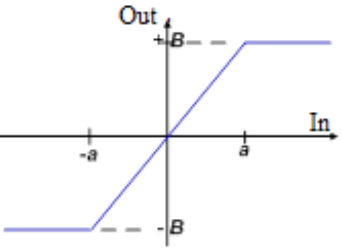
Figure 3. Static characteristics of a saturation relay.